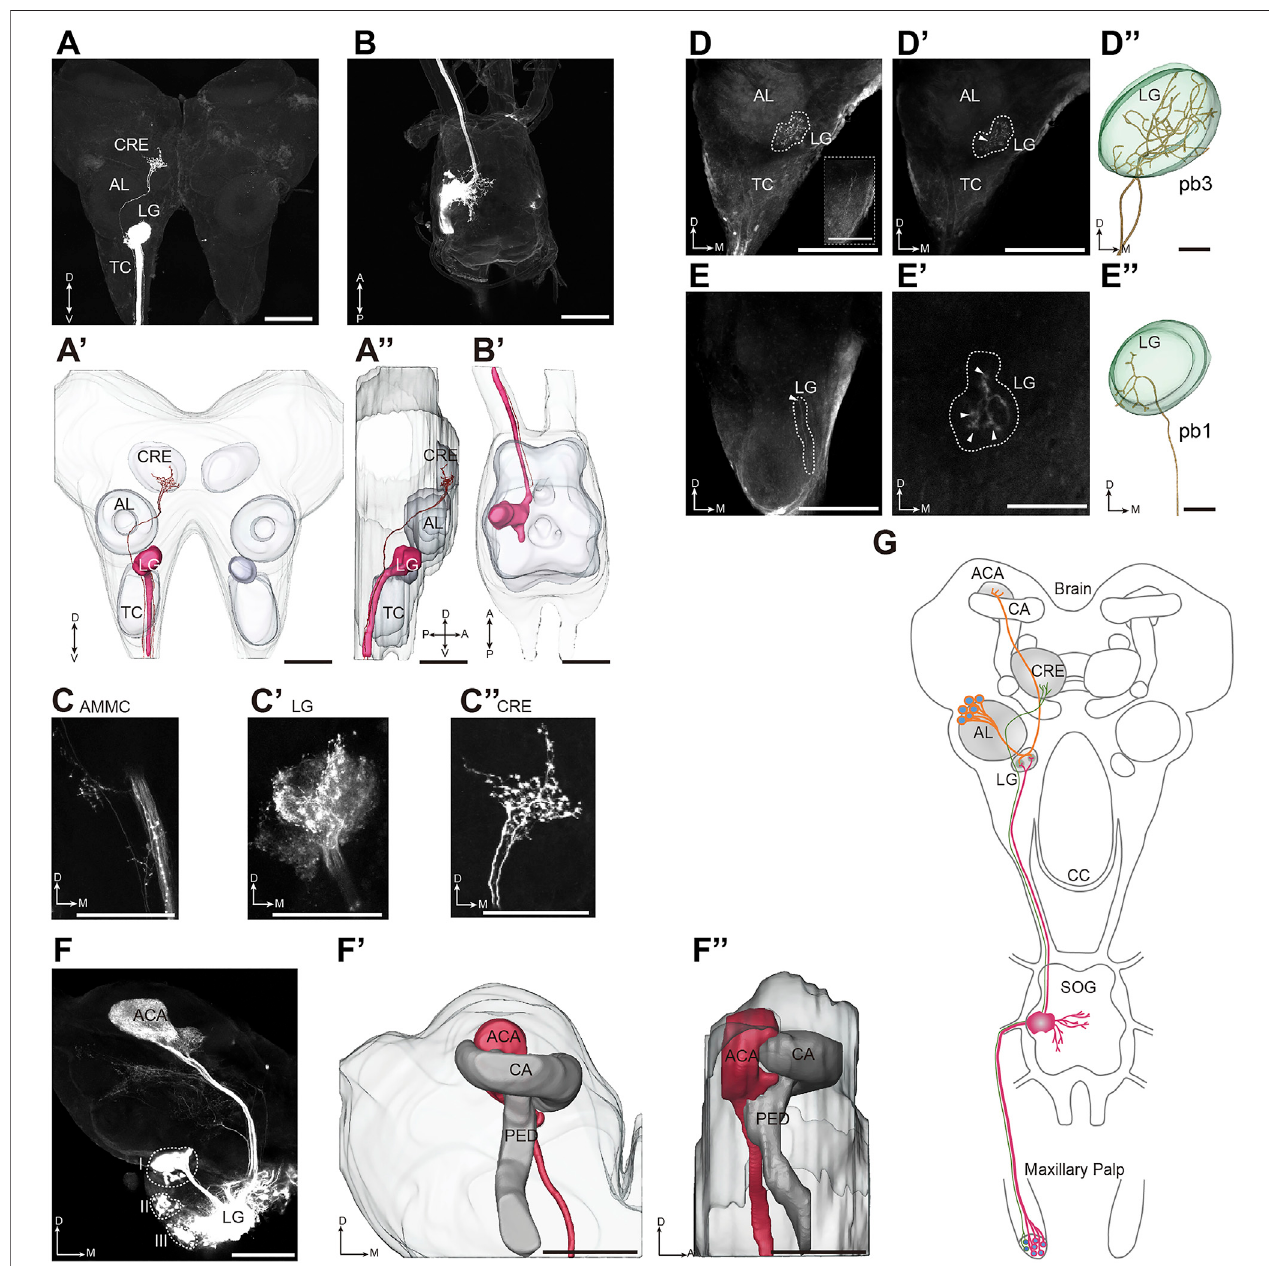
FIGURE6 | Two-order olfactory projection patterns underlying vomiting signaling in the brain. (A,B) Confocal images ofthe brain (A) and the SOG (B) withstained afferents originating from the maxillary palp. (A 9 ,A 99 ) Three-dimensional reconstruction of the stained neurons shown in (A) (frontal and lateral views, respectively). (B 9 ) Three-dimensional reconstruction of the stained neurons shown in (B) . (C-C 99 ) Terminals of sensory neuron axons originating from the maxillary palp innervate the AMMC (C) ,theLG (C 9 ), andtheCRE (C 99 ) . (D,D 9 ) Confocalimagesofthebrainwithstainedafferentsoriginatingfrompb3.Thedottedboxin (D) markstwoplexiof axonsoriginating from the pb3neurons running through the ipsilateral TC. The dotted linemarks the projected region inthe brain,and the whitearrow shows the axonal entry point into the LG. (D 99 ) Three-dimensional reconstructed images of the ORN axons shown in (D) . (E,E 9 ) Confocal images of the brain with stained afferents originatingfrompb1.Theprojectedregionismarkedbythedottedline.Thewhitearrowin (E) showstheaxonalentrypointintotheLG,andthewhitearrowsin (E 9 ) show four branches of the axons in the LG. (E 99 ) Three-dimensional reconstructed images of the ORN axons shown in (E) . (F) Confocal images of the main glomerular lobe- calycal pathway obtainedbyselectivestainingofPNslinked totheLG. The LGisspeci fi cally connected totheACA oftheMB. (F 9 ,F 99 ) Three-dimensionalreconstruction showing the overall projection pathway of the PNs in the LG (frontal and lateral views, respectively). The dotted line marks the soma clusters of the PNs. (G) Schematic representationoftheneuralcircuitoflocustvomiting.SOG,suboesophagealganglion;CC,circumoesophagealconnective;TC,tritocerebrum;DC,deutocerebrum;PC, protocerebrum; AL, antennal lobe; LG, lobus glomerulatus; CRE, crepine; AMMC, antennal mechanosensory and motor center; MB, mushroom body; CA, calyx; ACA, accessory calyx; PED, pedunculus; A, anterior; D, dorsal; M, medial; P, posterior; and V, ventral. Scale bars: 200 µm in (A-A 99 ) , (B-B 99 ) , (D-D 9 ) , (E-E 9 ), and (F-F 99 ) ; 100 µm in (C-C 99 ) and the dotted box of (D) ; and 50 µm in (D 99 ) and (E 99 ) .